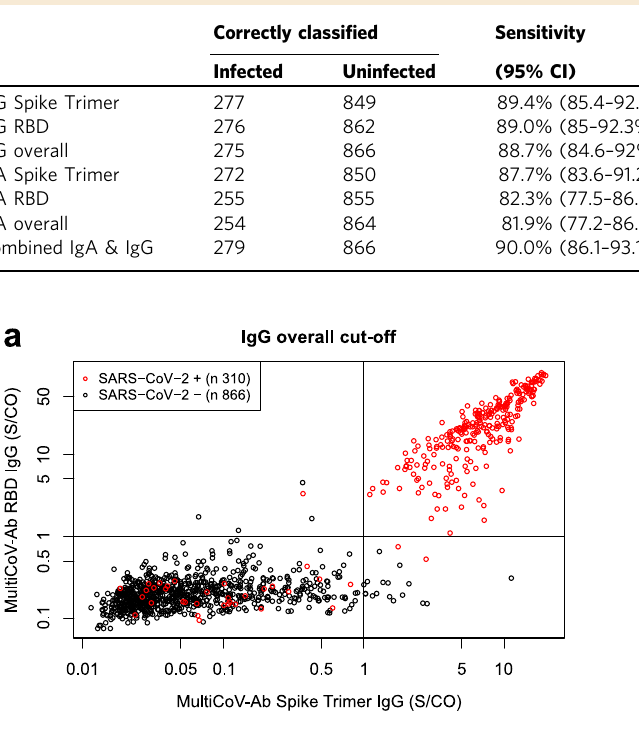
Table 3 MultiCoV-Ab sensitivity and speci fi city of extended sample set for IgA and IgG based on a single analyte or a combined cut-off of Spike Trimer and RBD (IgG or IgA overall) or combined isotype cut-off (IgG and